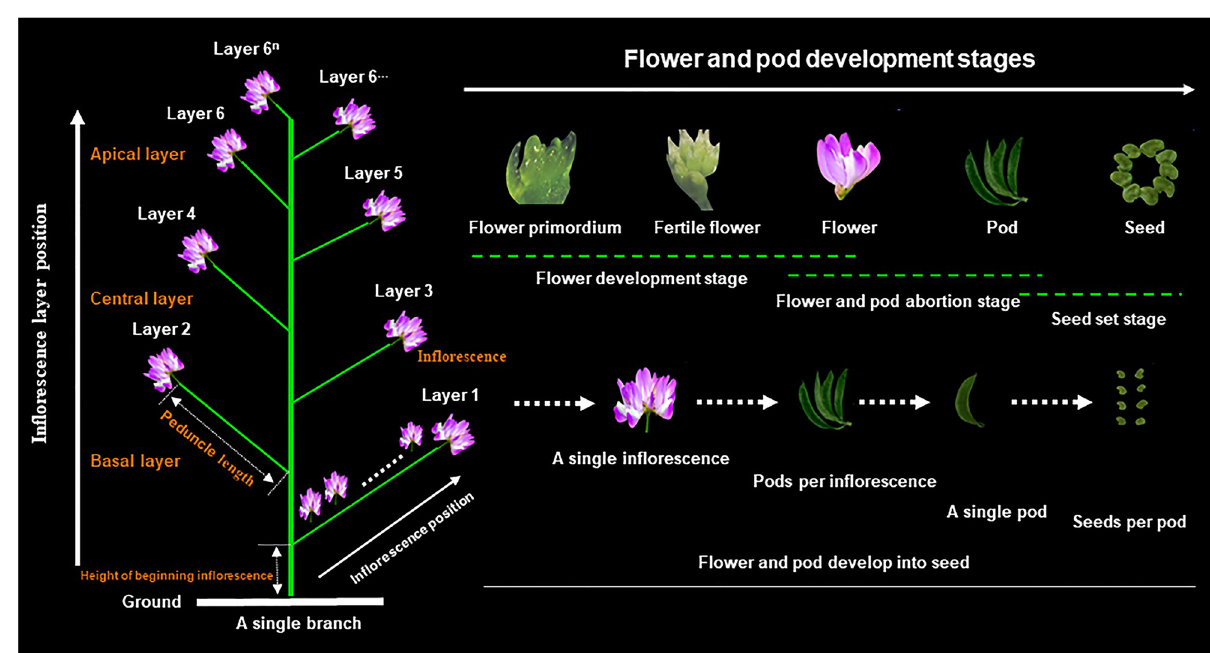
Fig 1. Morphological structure and the regularity of flower and pod development in Chinese milk vetch. These photographs were captured using a stereomicroscope (SZN-6 (45x), OPTIKA S.R.L., ITALY). The left panel illustrates the inflorescence layers (from bottom to top). The left bottom panel illustrates the inflorescence position of the inflorescence layers, and the inflorescences are numbered according to their positions relative to the rachis from most proximal to most distal. The panel on the upper right side illustrates the flower and pod developmental dynamics in three stages: the flower development stage (from the first appearance of the flower primordium to pollen maturity), flower and pod abortion stage (i.e., the fall-off stage of the flower and pod), and seed set stage (flower and pod develop into seed). The bottom right panel illustrates the processes of inflorescence development into seeds. The illustrations and photographs are not to scale; for reference, the flower widths are approximately 4.5 mm at pollen maturity, and the pod width and pod length are approximately 3 mm and 23 mm, respectively.